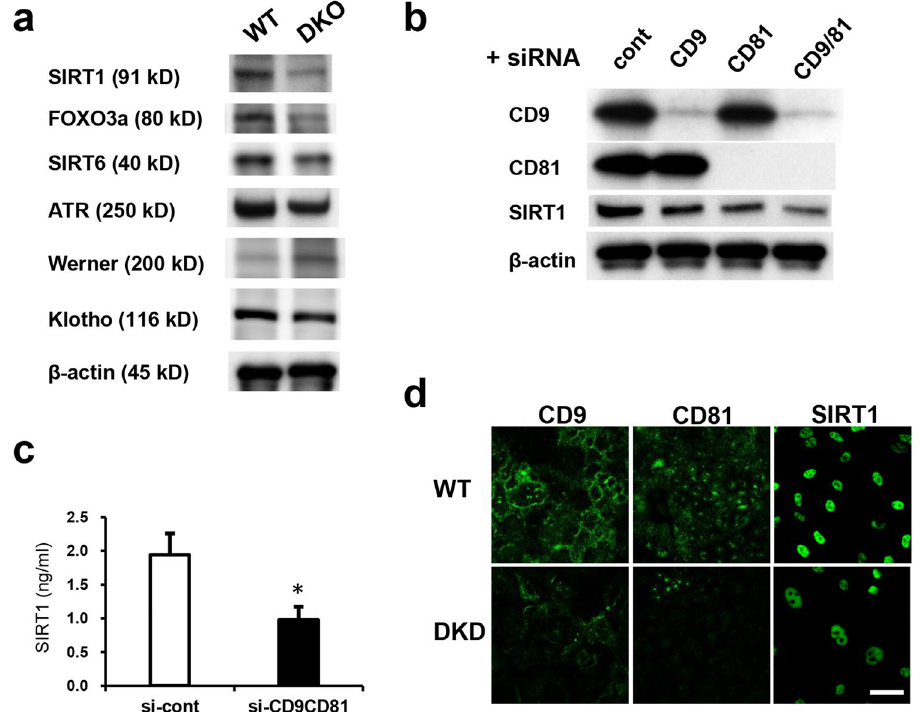
Figure 5. Double deletion of CD9/CD81 results in reduced SIRT1 expression. ( a ) Immunoblot of the lungs for major aging molecules. Notably, expression of SIRT1, but not that of SIRT6, Klotho, WRN, and ATR, was reduced in DKO lungs. ( b ) Knockdown of CD9 and CD81 expression with siRNA in epithelial cells additively downregulated the expression of SIRT1. ( c ) SIRT1 expression by ELISA (n = 4). ( d ) SIRT1 expression by immunocytochemistry. Bars represent means ± SD; * P < 0.05 versus si-cont. Scale bar, 50 µ m for ( d